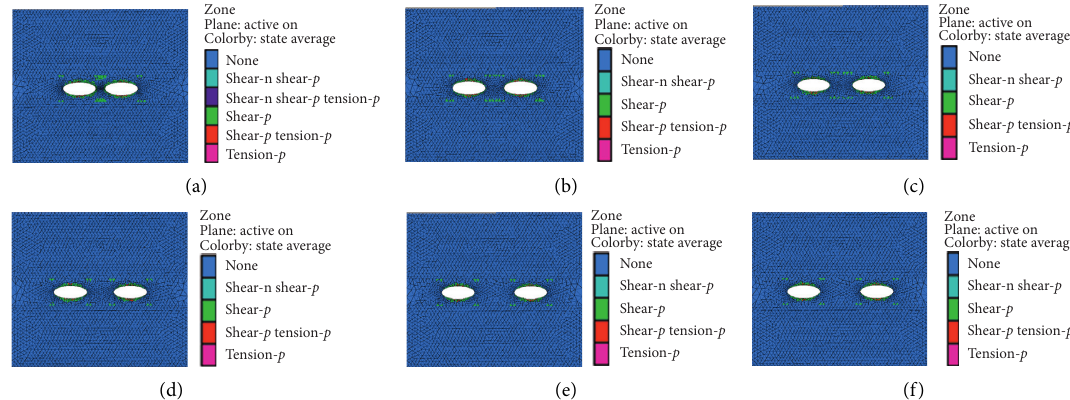
Figure 15: Plastic zone distribution map of double-cavern horizontal salt rock underground storage with different pillar widths (20 a ). (a) d � 40m; (b) d � 80 m; (c) d � 100m; (d) d � 120m; (e) d � 140m; and (f) d �